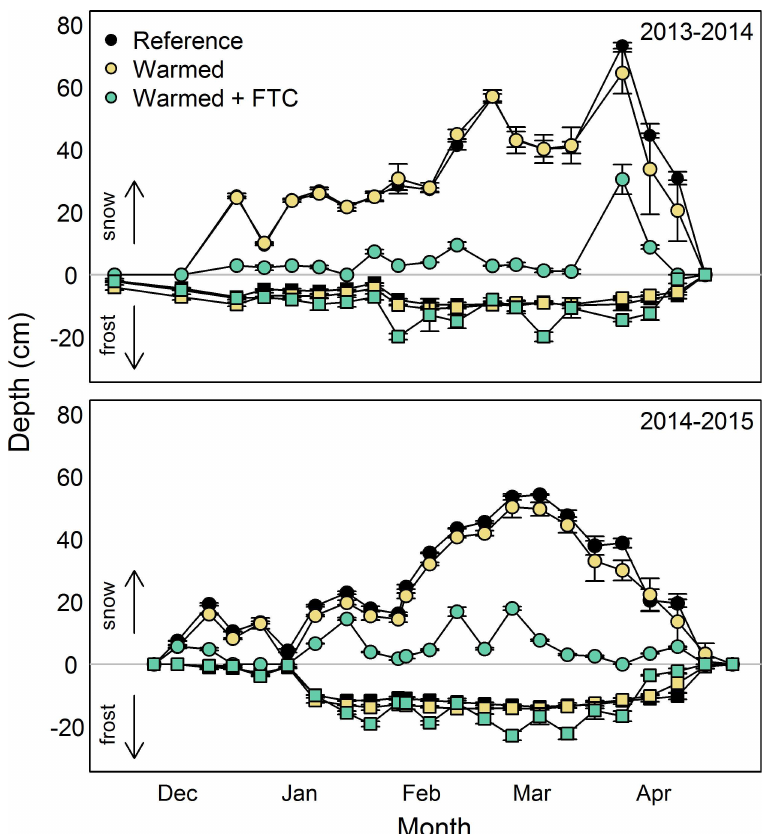
Fig 3. Mean snow ( > 0 cm, circles) and frost depth ( < 0 cm, squares) in reference , warmed , and warmed + FTC plots. Error bars are standarderror of the mean. Upper figure containsdata from the 2013/2014 winter and lower figure containsdata from the